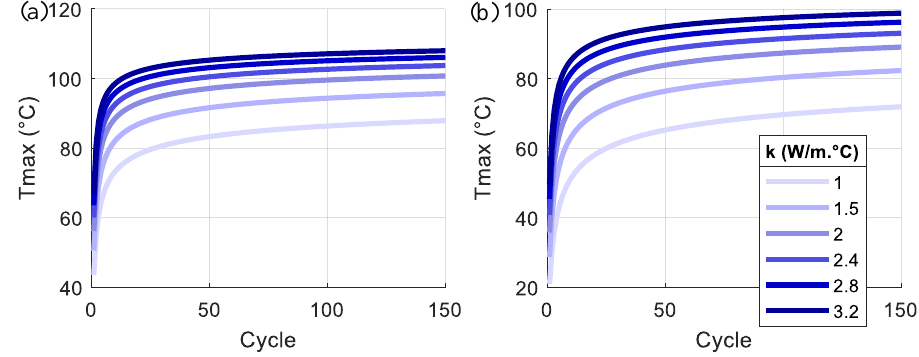
Figure 18. Maximum temperature in each loading cycle for different k at: ( a ) the midpoint of the pile section; ( b ) the outer surface of the pile section.